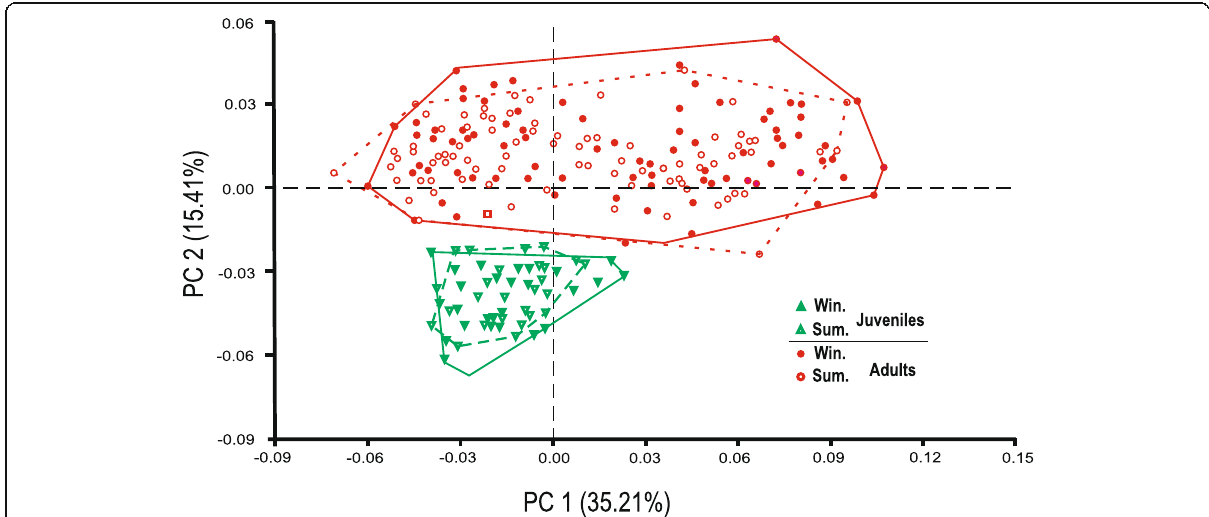
Fig. 3 Scatter plot of PC1 and PC2 for left body-half of P. pruinosus . The plot reflects the overlap between winter and summer individuals for adults and juveniles